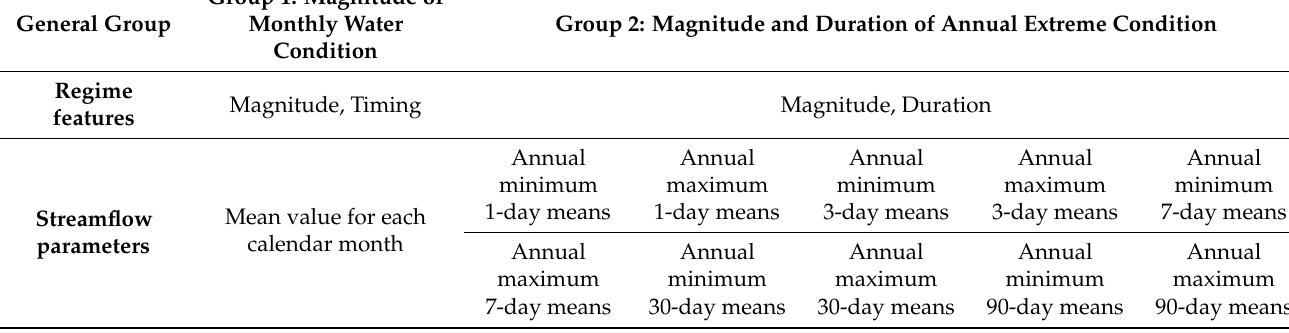
Table 3. Hydrologic parameters used in the